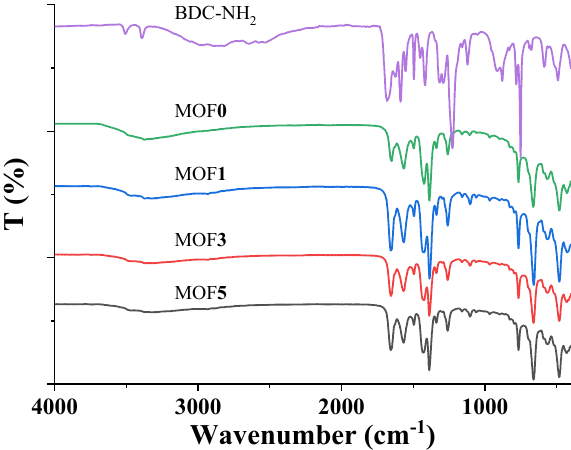
Figure 2. Fourier transform infrared spectra of the obtained MOF products.